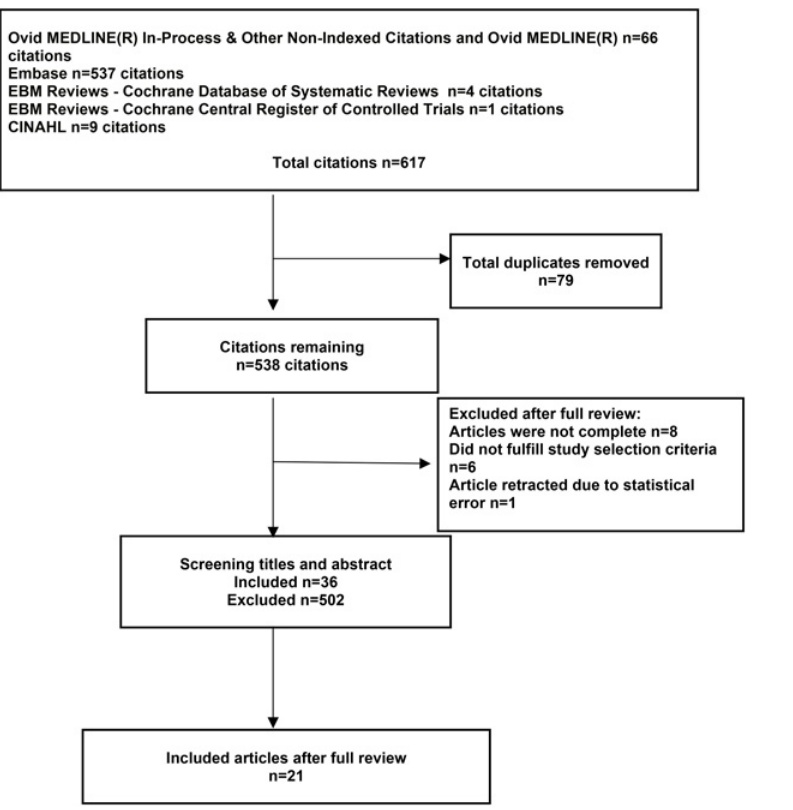
Fig 1. Systematic review flow